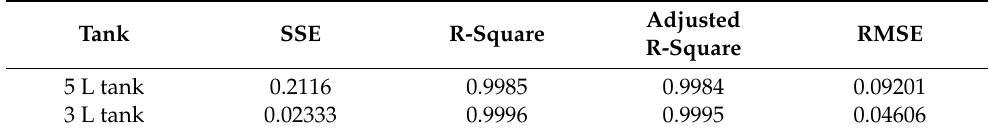
Figure 8. Experimental error diagram of overall heat transfer coefficient.